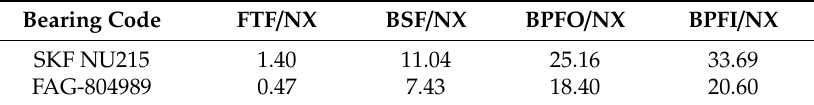
Figure 13. ( a ) The overall view of the test rig; ( b ) the traction motor unit. Table 1. The parameters of the tested bearings.